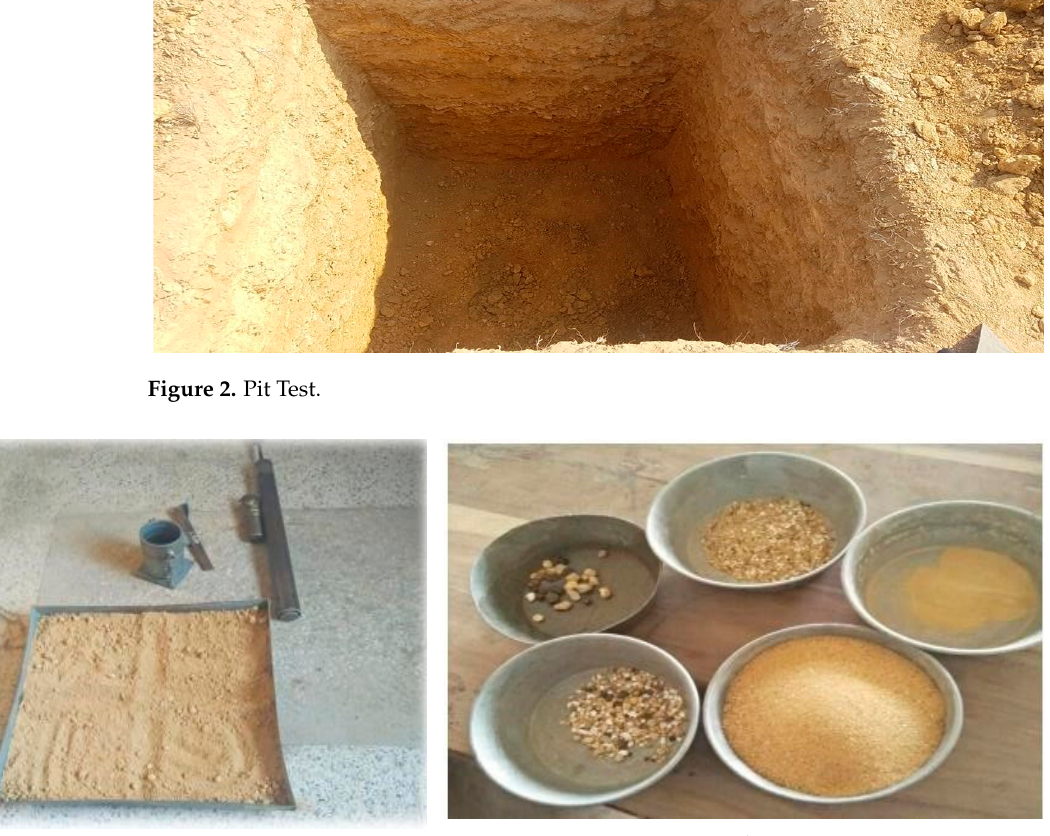
Figure 3. ( a ) Quartering of representative sample ( b ) Sieved samples.